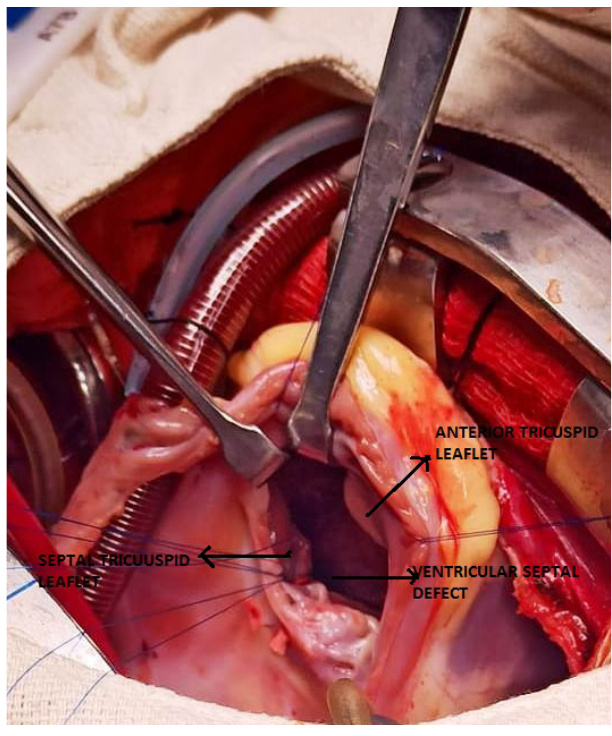
Fig. 1 - Intraoperative